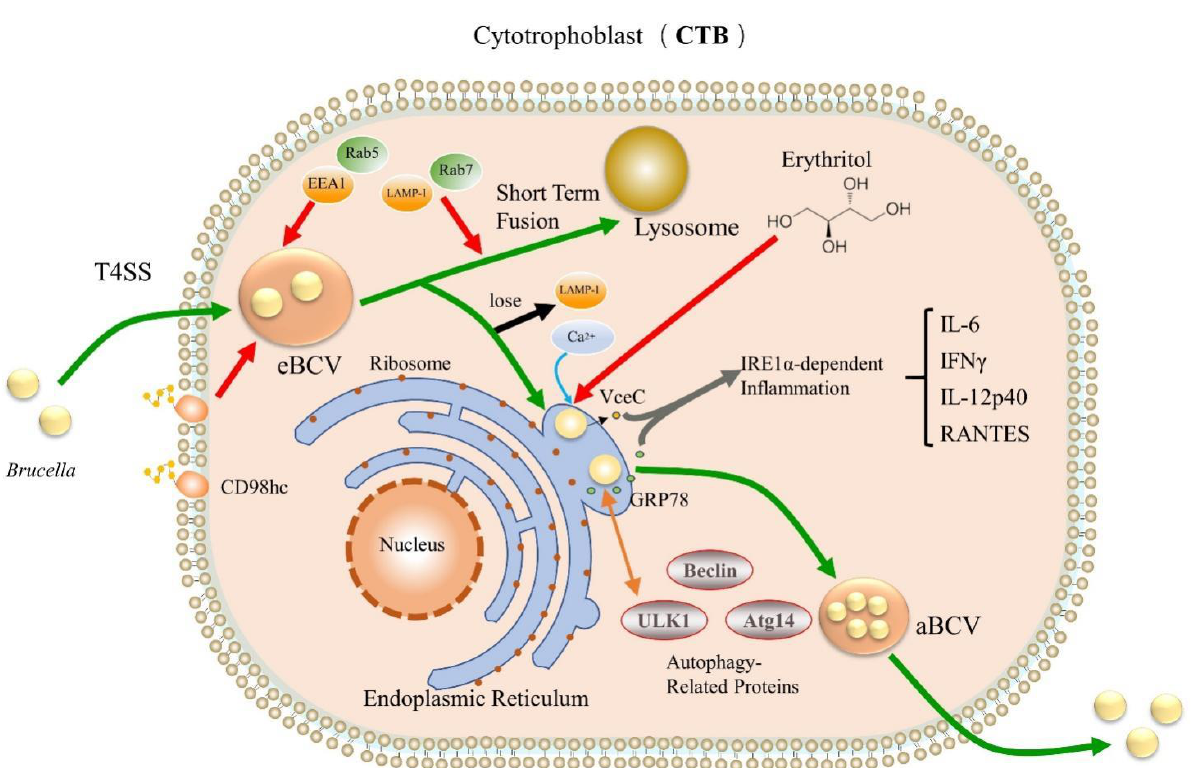
Figure 1. Intracellular process of Brucella invading CTB. Green arrows indicate the infection pathway of Brucella ; red arrows indicate adsorption, acquisition or capture; gray arrows indicate co-cause and mediation; orange arrows indicate interactions; blue arrows indicate binding; black arrows indicate loss.